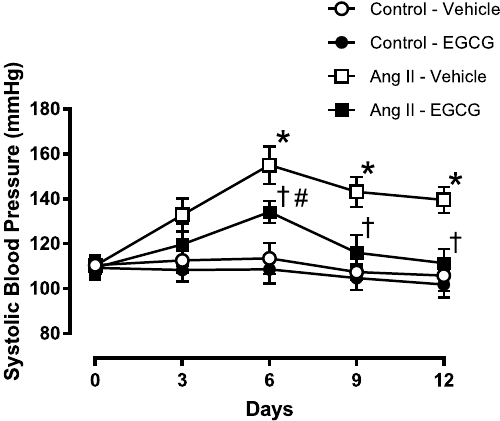
Figure 1. The average systolic blood pressure (SBP) in control and angiotensin (Ang) II-infused hypertensive mice with and without in vivo treatment with epigallocatechin gallate (EGCG). Data are expressed as means ± SEM (n = 6–7). *p ≤ 0.05 Ang II—vehicle compared to control—vehicle; † p ≤ 0.05 Ang II—vehicle compared to Ang II—vehicle; # p ≤ 0.05 Ang II—vehicle compared to